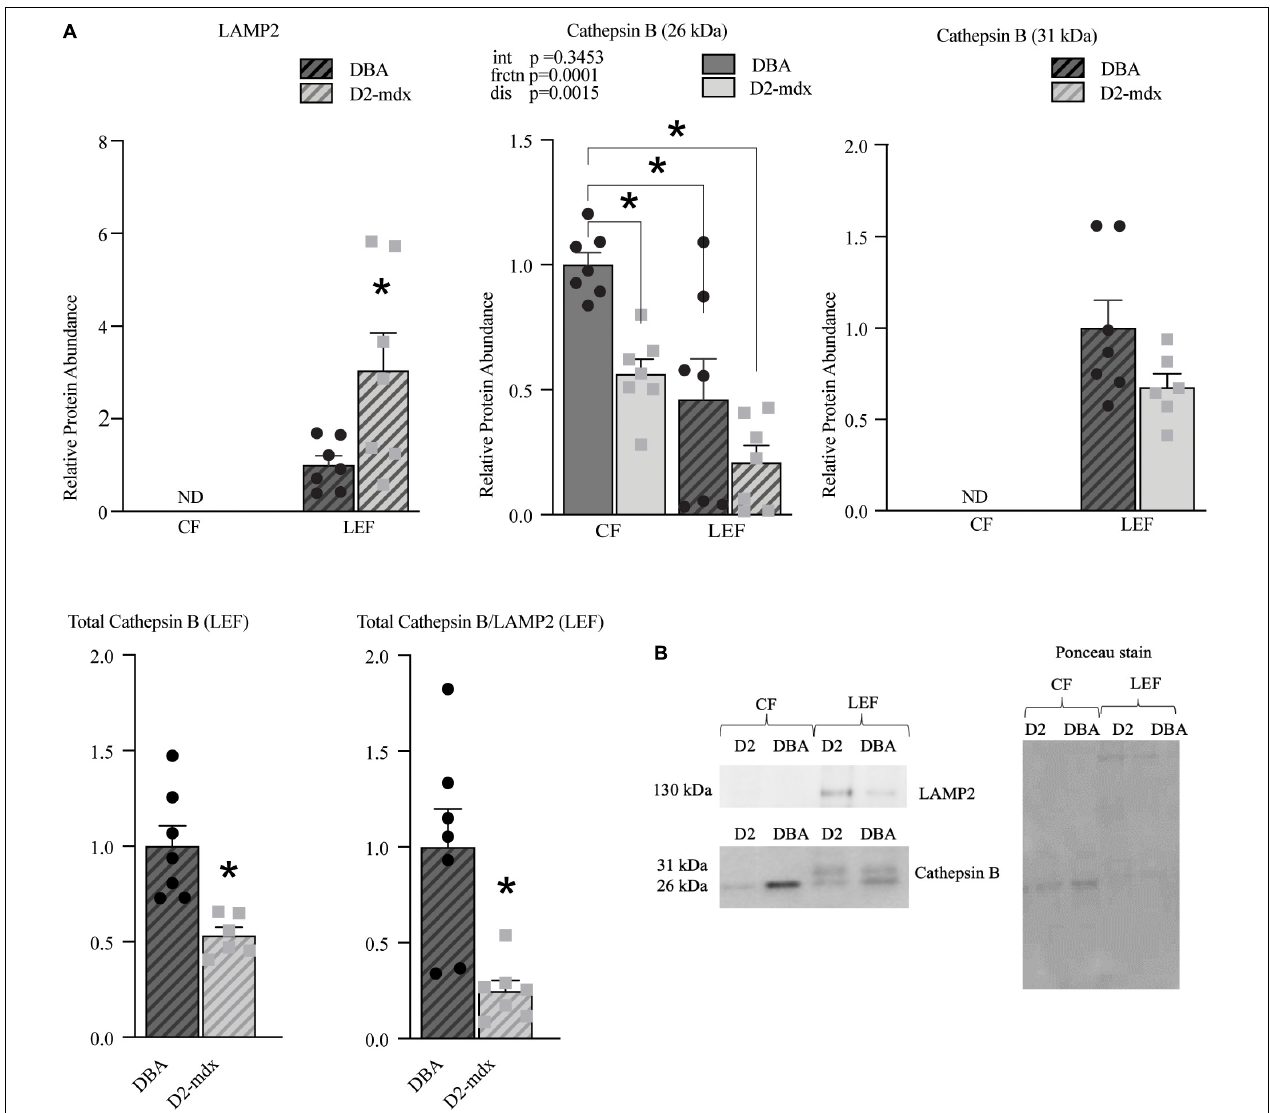
FIGURE 6 | Lysosomal abundance and enzyme markers assessed in cytosolic and lysosome-enriched fractions from D2-mdx and DBA gastrocnemius muscles. Western blot protein quantifications of LAMP2, Cathepsin B (26kDa), Cathepsin B (31kDa), total Cathepsin B, and ratio total Cathepsin B/LAMP2 from cytosolic- and lysosome-enriched fractions of gastrocnemius muscles from 11 month old DBA and D2-mdx. (A) LAMP2 was detected only in LEF and it was increased in D2-mdx muscles compared to DBA. Within the cytosolic fraction, protein abundance of 26 kDa Cathepsin B was reduced in D2-mdx compared to DBA. The 31 kDa protein was detected only in LEF and was similar between groups. Total Cathepsin B (calculated as sum of optical densities of 31 kDa and 26 kDa) was decreased in D2-mdx LEF. Total Cathepsin B/LAMP2 was decreased in D2-mdx. (B) Representative western blot images and corresponding Ponceau stain image. Significance was established at p < 0.05. ( n = 7 mice per group). * Indicates significance between groups by post hoc test (linked by lines) or by T -test, as appropriate. p-values of main effects (frctn for fraction, dis for disease) and the interaction (int) are indicated, ND indicates not